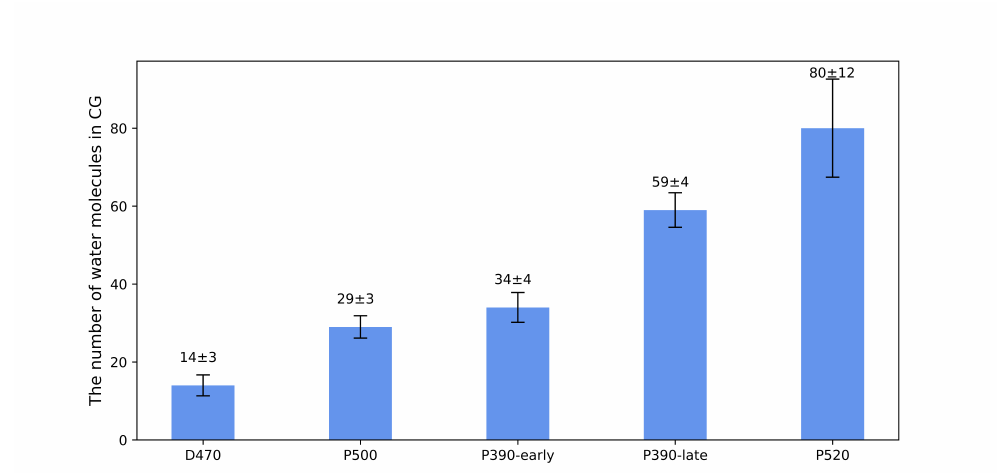
Figure 4. The number of water molecules at CG in all intermediates. The number of water molecules were counted by calculating the average number of all water molecules in CG in the last 50 ns trajectories in D470, P500, P390-early, P390-late, and P520 states.